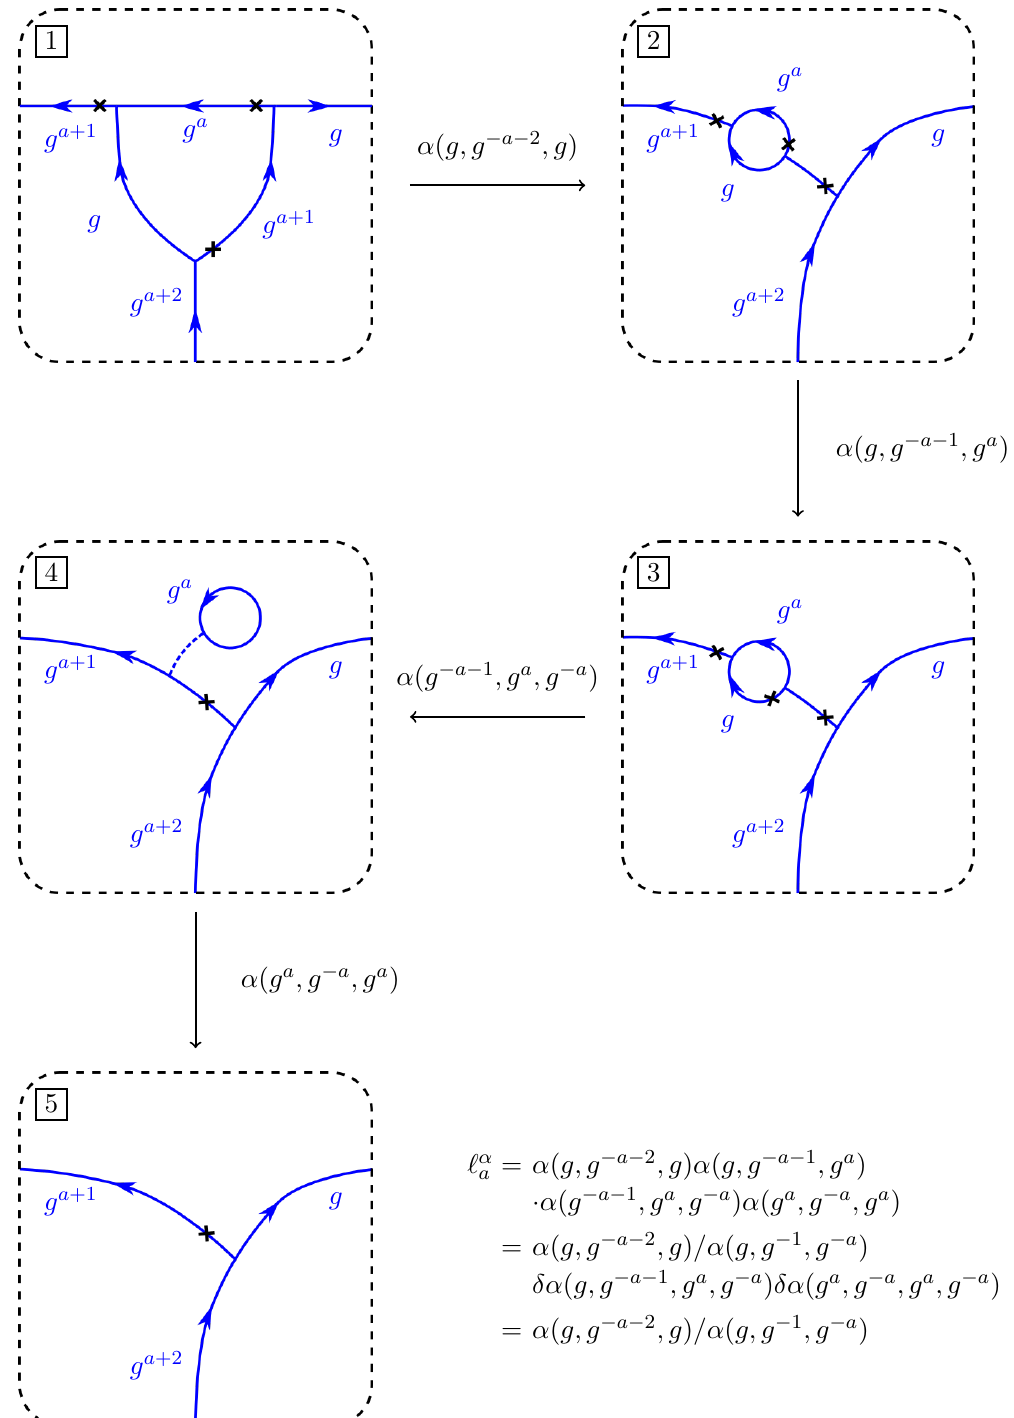
Figure 5 . Contracting the trivalent loop shown in step (1) can be performed in four crossings. This leads to an overall phase ‘ α = α ( g, g − a − 2 , g ) /α ( g, g − 1 , g − a ) a